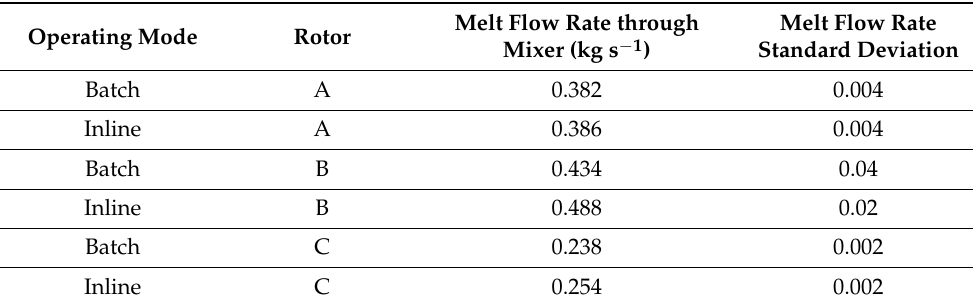
Table 4. Comparison of the predicted volume flow rate for the different rotors operating in batch and inline modes with rotor speed 1000